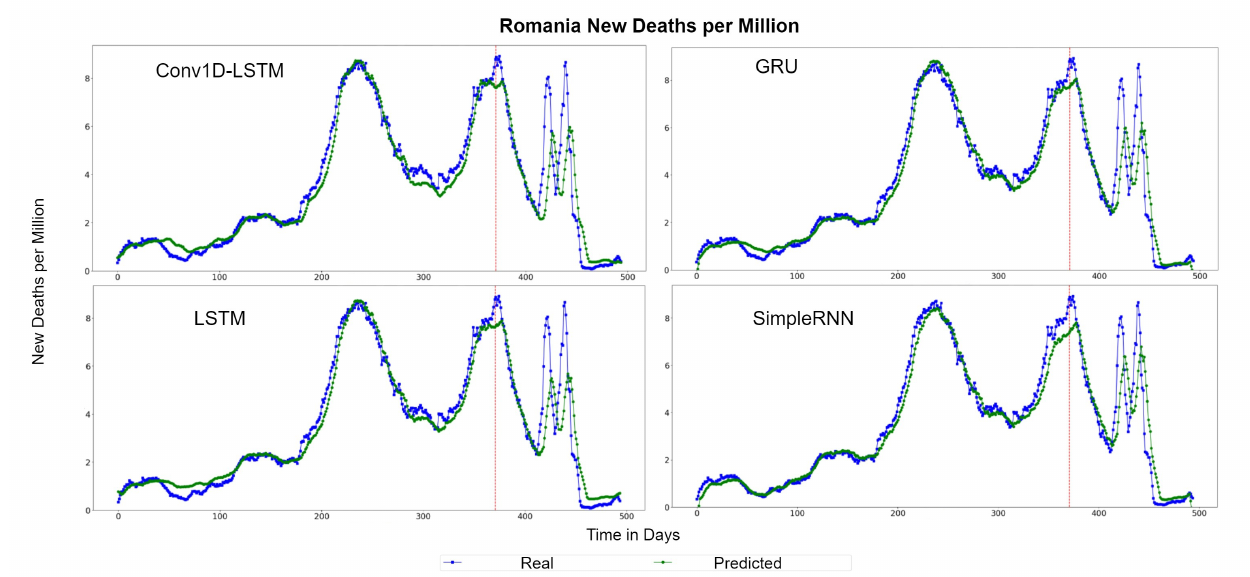
Figure 12. Romania’s new deaths per million real (blue line) and predicted (green line) values for each method, using the training, validation, and test datasets. The red line divides the train-validation (right size) and the test (left side)